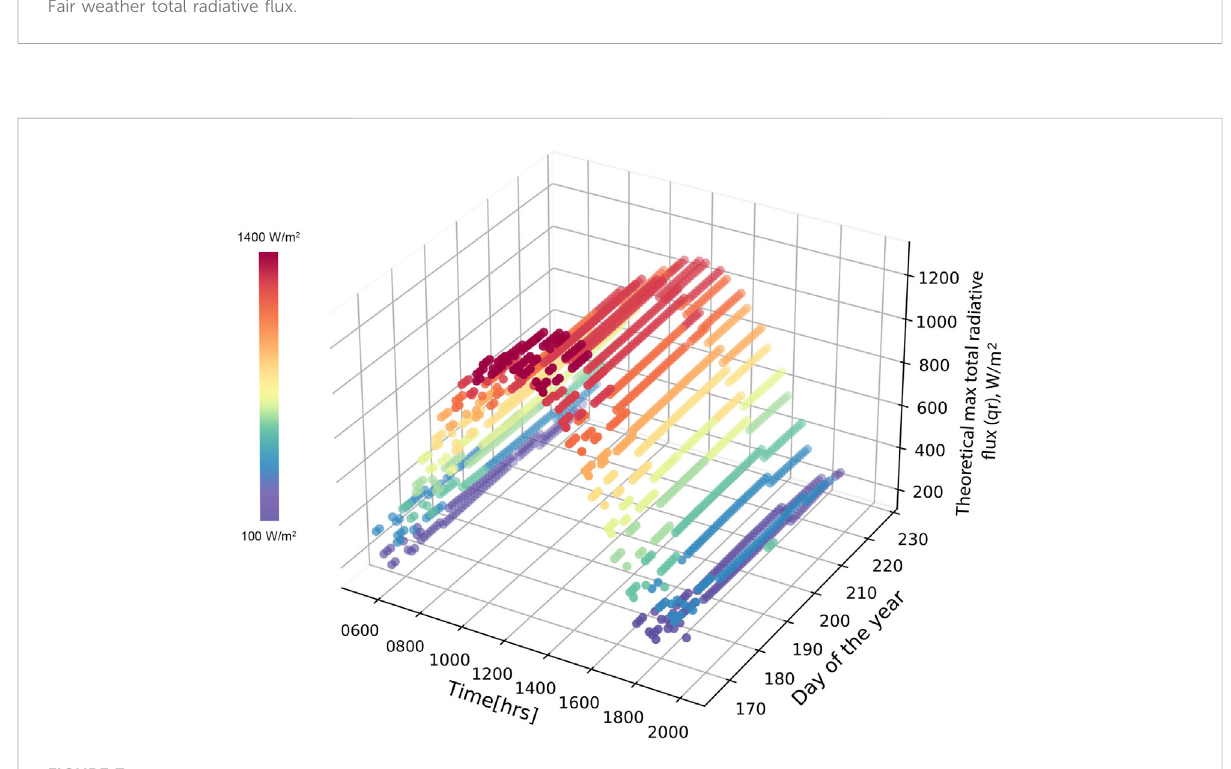
FIGURE 7 Theoretical maximum total radiative fl